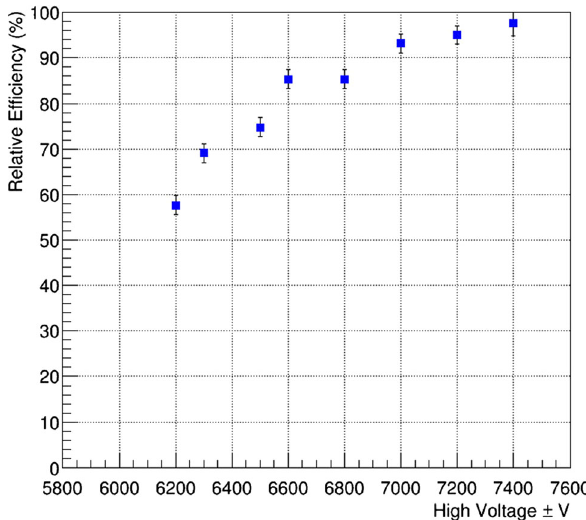
Fig. 11 Efficiency plateau at BEPCII